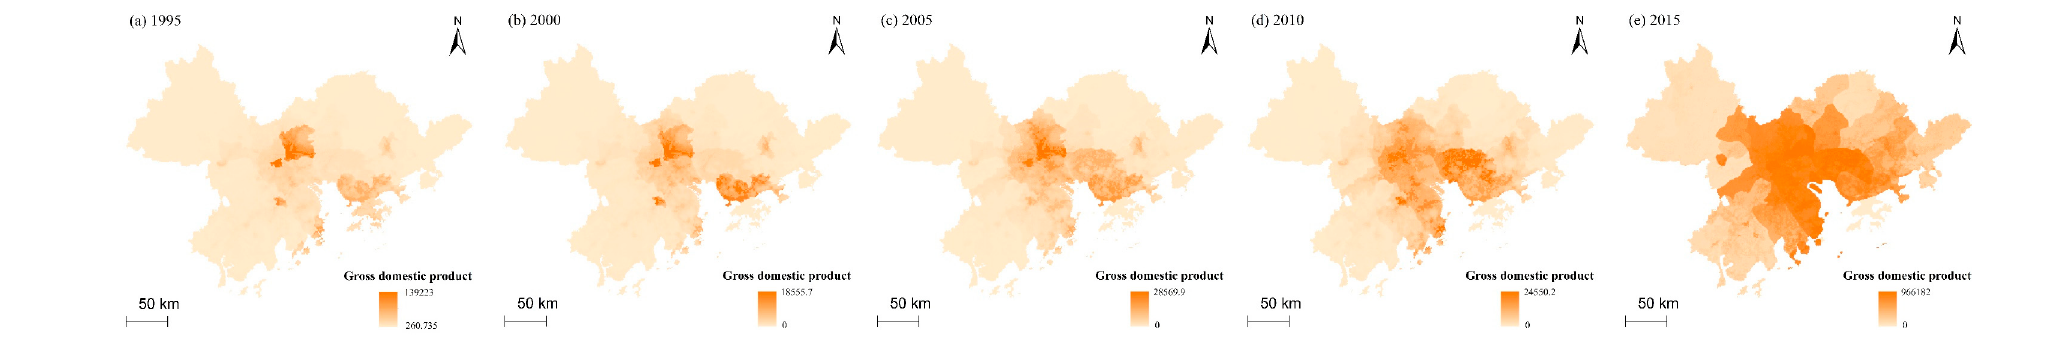
Figure A2. The spatial distribution of gross domestic product: ( a ) 1995, ( b ) 2000, ( c ) 2005, ( d ) 2010, ( e ) 2015.